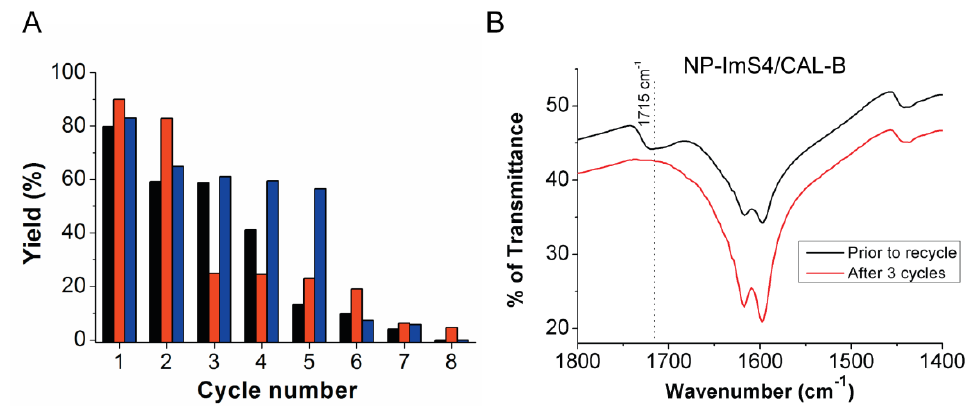
Figure 6. ( A ) Recycling of immobilized CAL-B for transterification reaction. The reaction percentage yield for each system is represented in colored bars: NP-ImS4/CAL-B (black bars), NP-ImS10/CAL-B (red bars) and NP-ImS18/CAL-B (blue bars). ( B ) Infrared spectra of NP-ImS4/CAL-B before (black line) and after (red line) the three reaction cycles.